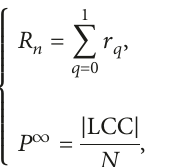
, G , and G and (b) a multipartite 1 2 3 , V , and V 1 2 3